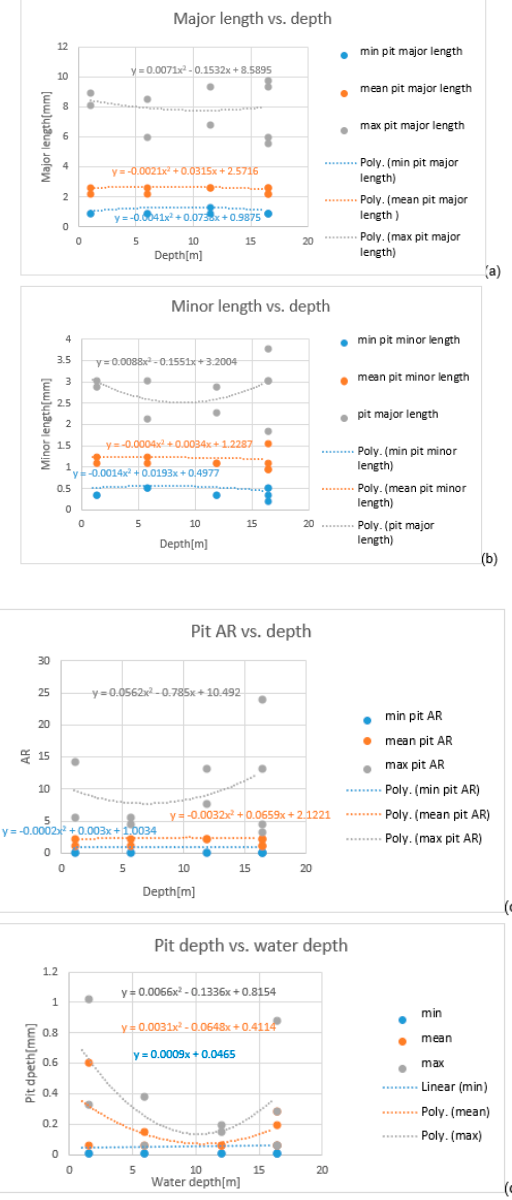
Figure 4. ( a – d ): Variation in pit characteristics with depth.